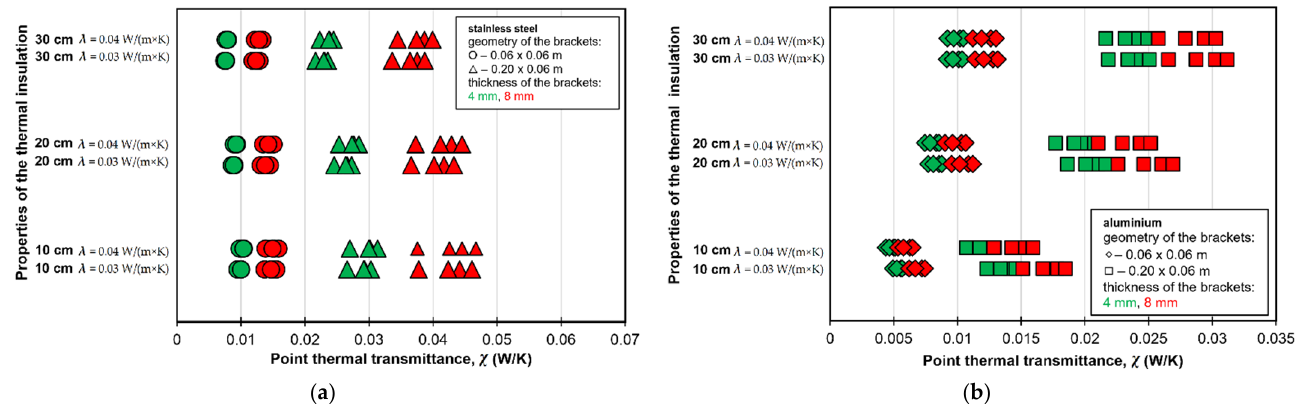
Figure 8. ( a ) Stainless steel brackets with thermal breaks fixed with a single 5 cm long anchor steel anchor in 20 cm thick RC wall. ( b ) Aluminium brackets with thermal breaks fixed with a single 5 cm long steel anchor in 30 cm thick masonry wall.